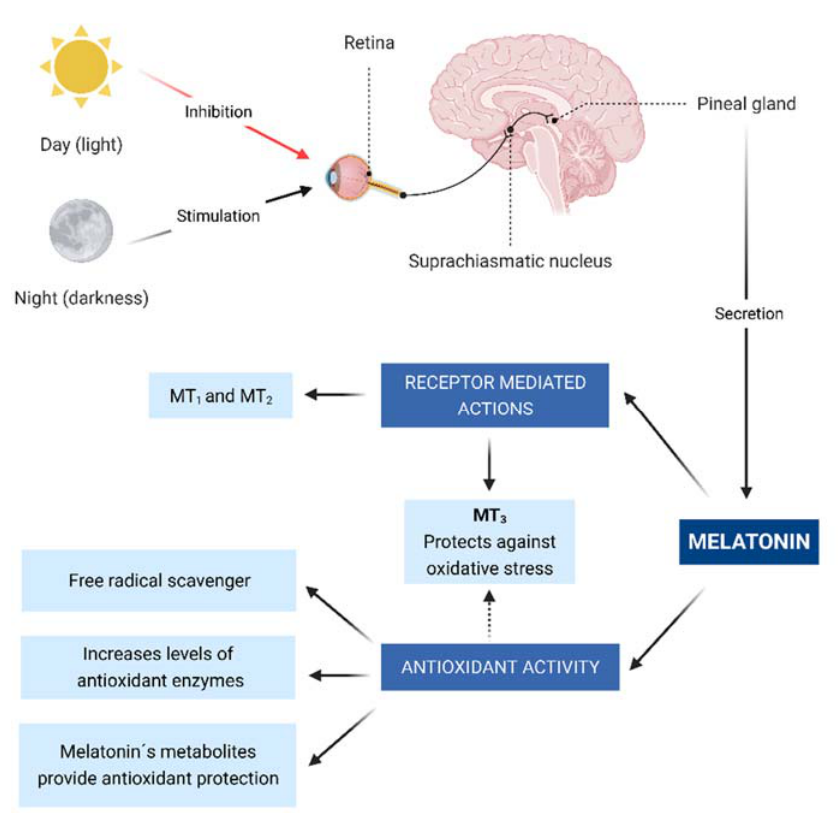
Figure 1. Neural control of pineal melatonin synthesis and its physiological effects via receptors mediated and non-mediated actions (antioxidant activity). Daylight inhibits the pineal production of melatonin while darkness stimulates it. Melatonin acts in receptors MT 1 to 3. MT3 is important due to its antioxidative